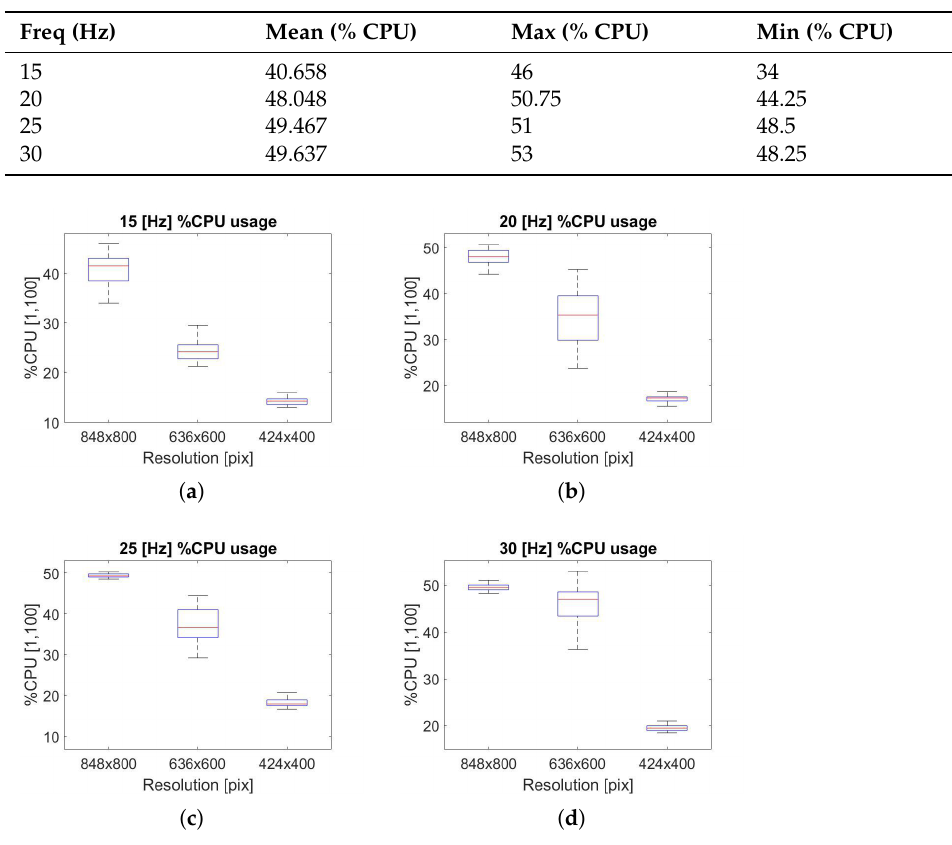
Table 5. High-resolution CPU usage values.